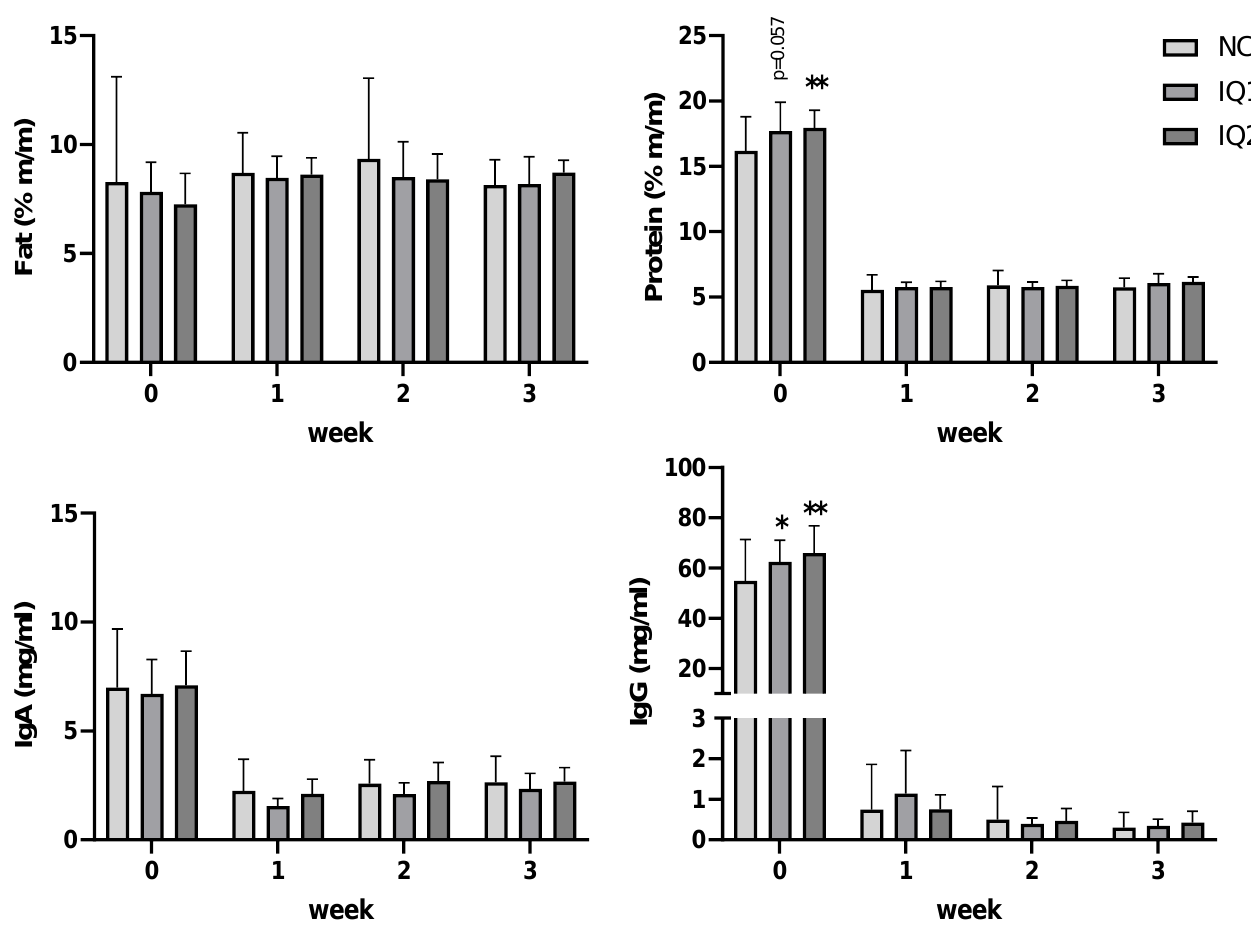
Figure 3. Fat and protein (%, top graphs), immunoglobulin A and immunoglobulin G (mg/mL; lower graphs) content in colostrum and milk. Sows received either a basal diet (NC), or supplementation with isoquinoline alkaloids (IQ) during gestation (90 ppm) and lactation (150 ppm) (IQ1), or only during the lactation period (IQ2). Milk collection was performed once a week from farrowing (week 0) until day 21 of lactation (3rd week). Data presented as mean ± SD. Statistical differences were considered when p < 0.05, as indicated with * (*, p < 0.05; **, p < 0.01), statistical trends were considered when 0.1 > p > 0.05.